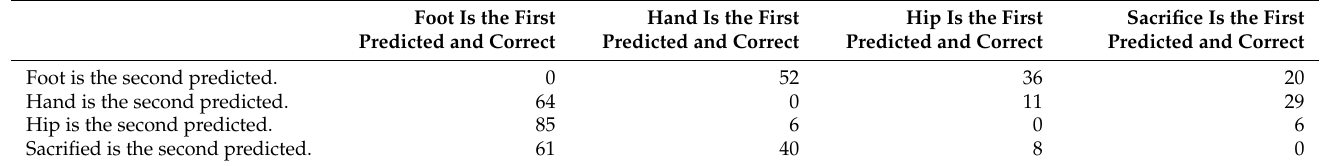
Table 4. The number of predicted results in the first and the second topmost predicted results when the actual throwing technique is resulted in the first rank. For example, when the foot category is predicted in the first rank and the result matches to the actual throwing technique, the number of predicted cases as the hand category in the second topmost predicted category is 64. Foot Is the First Hand Is the First Hip Is the First Sacrifice Is the First Predicted and Correct Predicted and Correct Predicted and Correct Predicted and Correct Foot is the second predicted. 0 52 36 20 Hand is the second predicted. 64